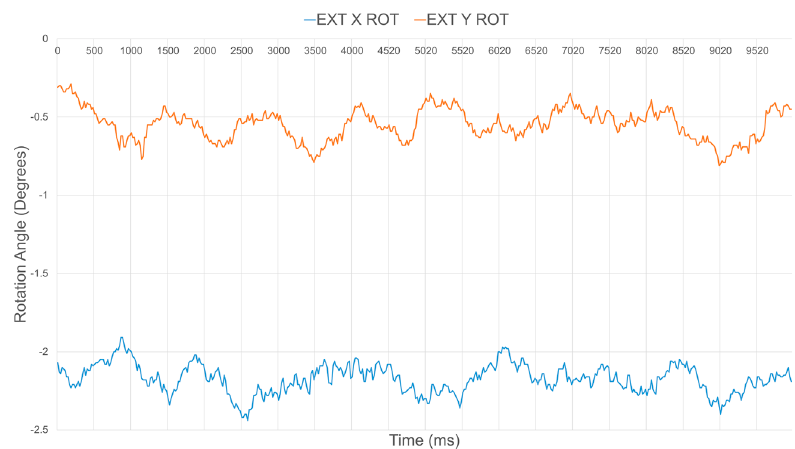
Figure 18. Uncalibrated orientation estimates for ground truth relative orientation of a surface with 0° rotation about both the X and Y axes.